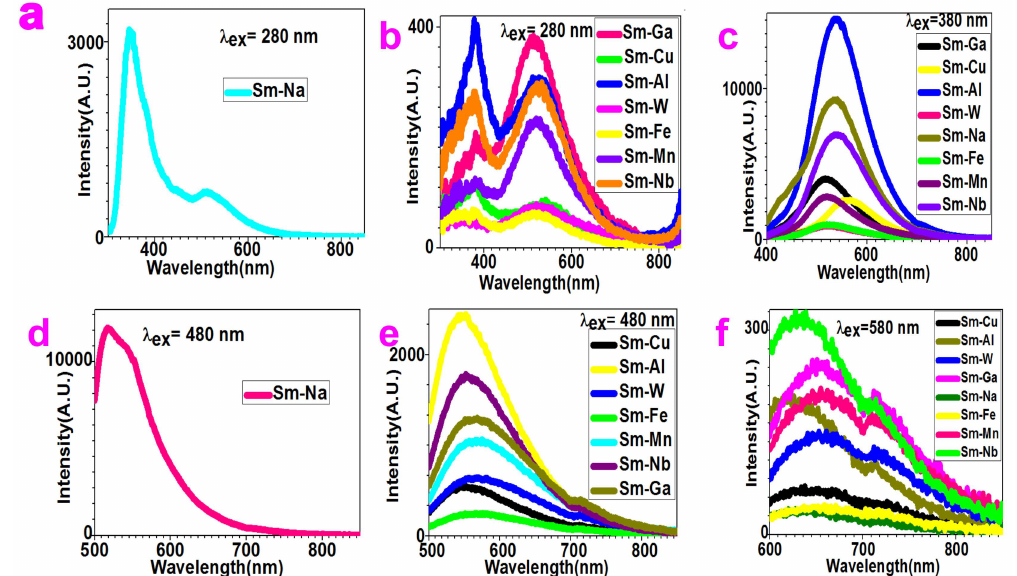
Figure 5. Polychromatic-photoluminescence spectra of Sm–Fe, Sm–Ga, Sm–Mn, Sm–Na,